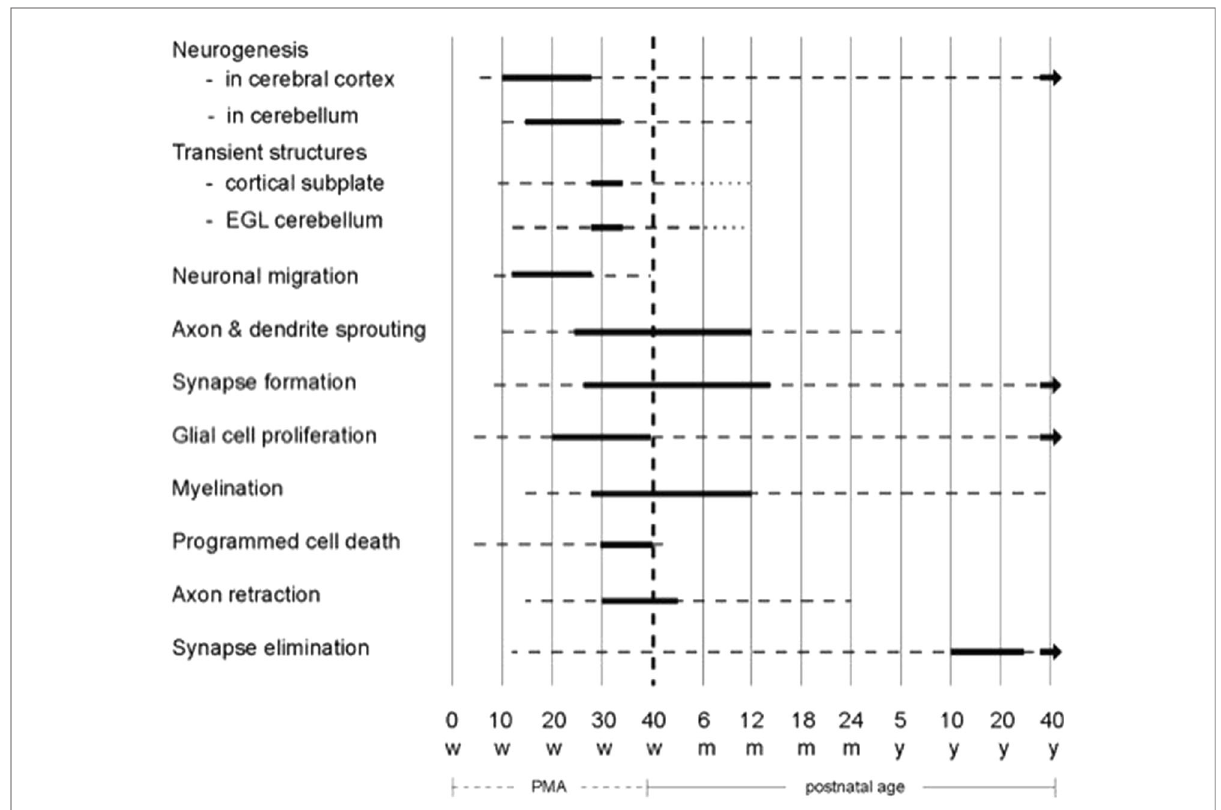
FIGURE 1 Schematic overview of the developmental processes occurring in the human brain. The bold lines indicate that the processes mentioned on the left side are very active, the broken lines denote that the processes still continue but less abundantly. The diagram is based on reference (9). EGL= external granular layer; m=months; PMA=postmenstrual age; w=weeks; y=years. Figure reproduced with permission from “ Early Detection and Early Intervention in Developmental Motor Disorders — from neuroscience to participation ” by Mijna Hadders-Algra (ed.) published by Mac